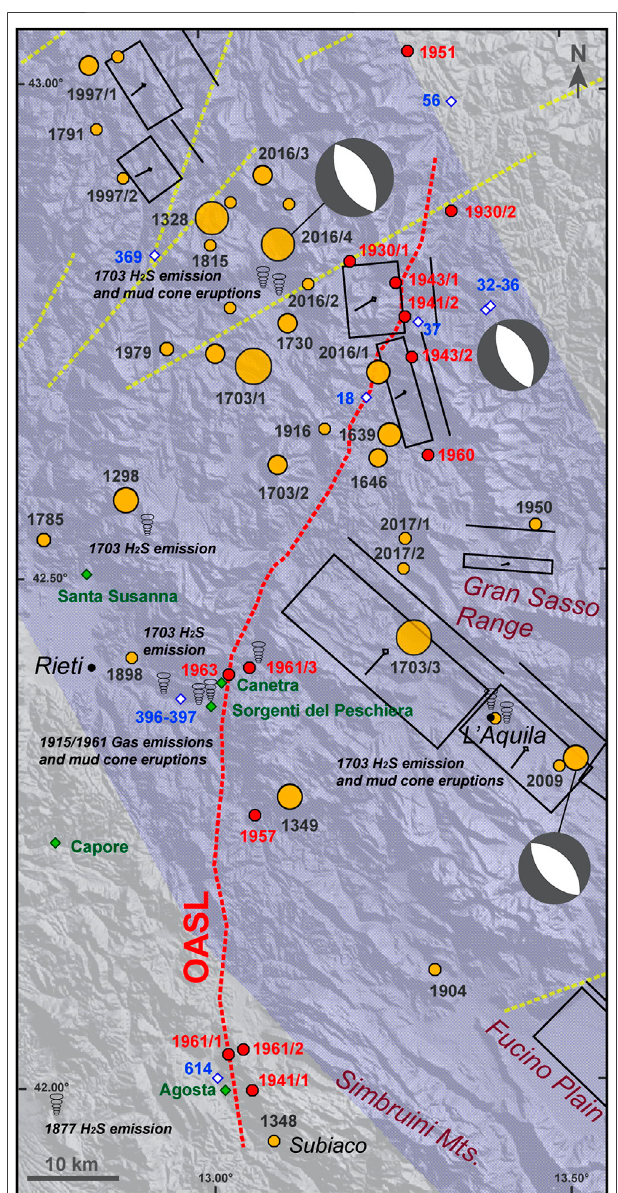
FIGURE 11 | Seismogenic faults, transverse lineaments, thermal springs and CO 2 emissions in the central Apennines (see Figure 4 for location). The black boxes are the surface projections of Individual Seismogenic Sources from the DISS database: they are assumed to have caused — from north to South — the September 26, 1997 (M w 6.0), the October 14, 1997 (M w 5.6), the August 24, 2016, M w 6.2, Amatrice (sources from Valensise et al., 2016), the February 2, 1703, M w 6.7, and the April 6, 2009, M w 6.3, L ’ Aquila earthquakes. Transverse lineaments are shown by yellow dashed lines, and the OASL is highlighted in red. Thermal springs are shown by blue diamonds along with their ID from the Database of Thermal Springs . CO 2 emissions are shown by green diamonds and labeled with their name from the database available at http://googas.ov.ingv.it. The 3D spiral symbols locate gas emissions, mud cone eruptions and H 2 S emissions that were activated following the